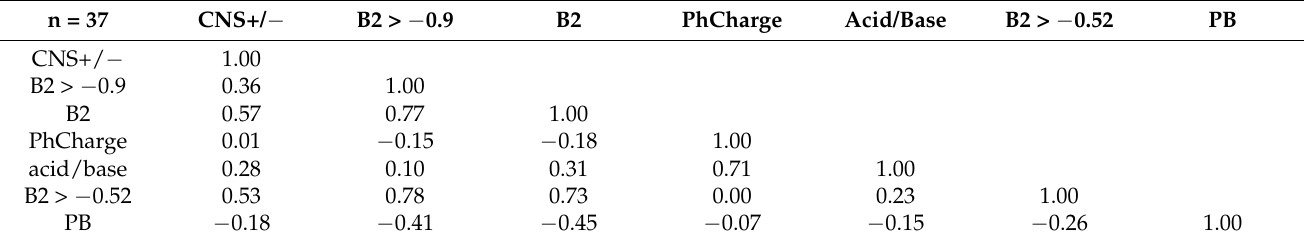
Table 3. Correlation matrix of the most important molecular descriptors for crossing the BBB.